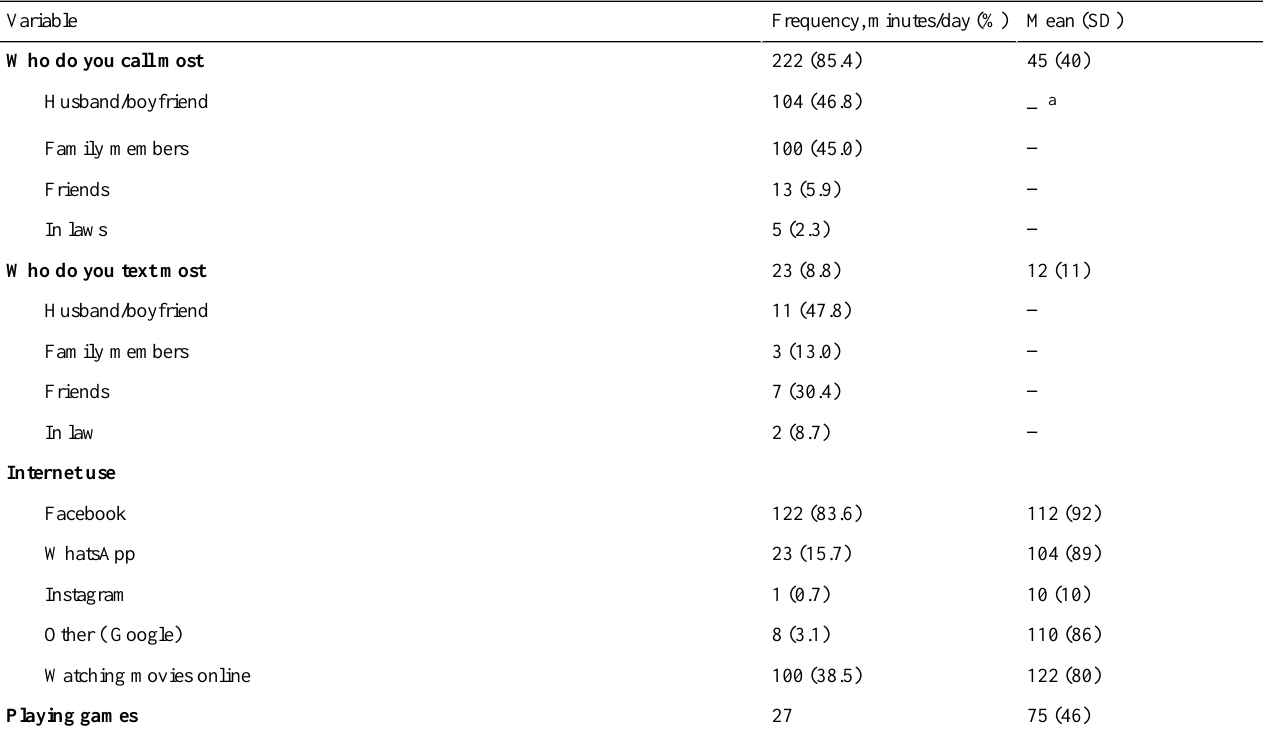
Table 2. Mobile phone patterns of use among perinatal adolescents